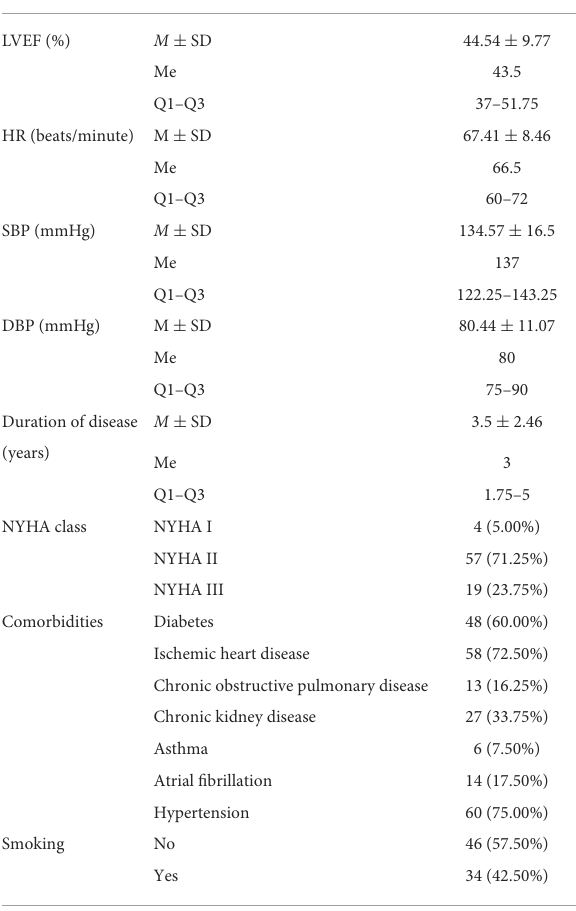
TABLE 2 Clinical characteristics of the study group ( N =